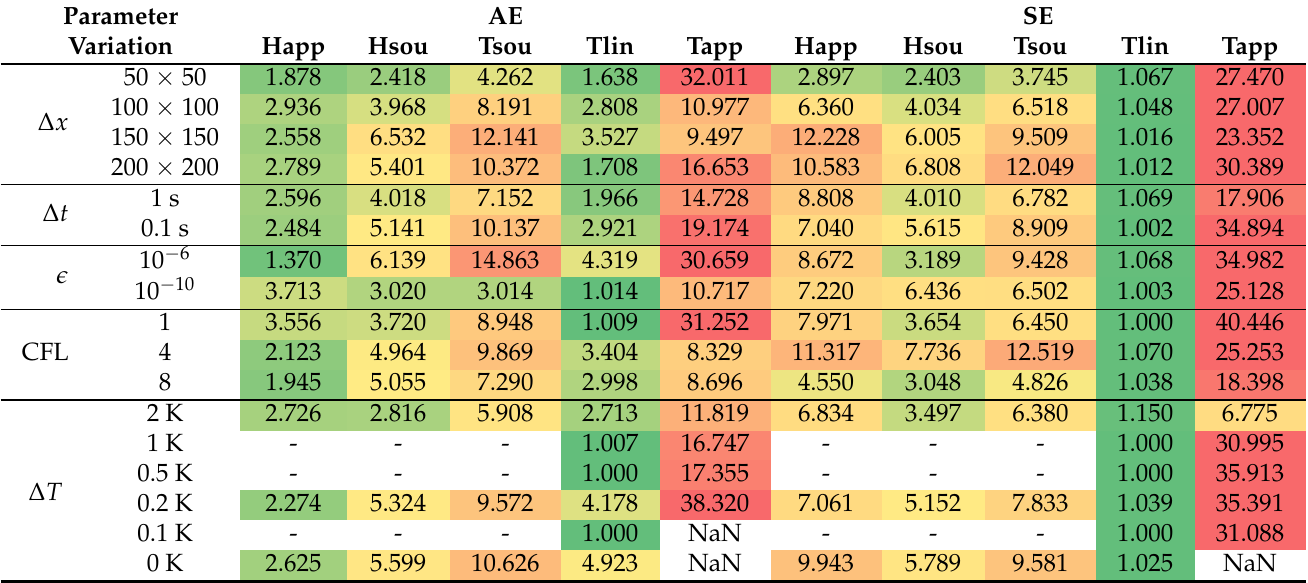
Figure 9. Underrelaxation factors for the AE and the SE case (clear and striped, respectively). Table 4. Mean values of the normalized